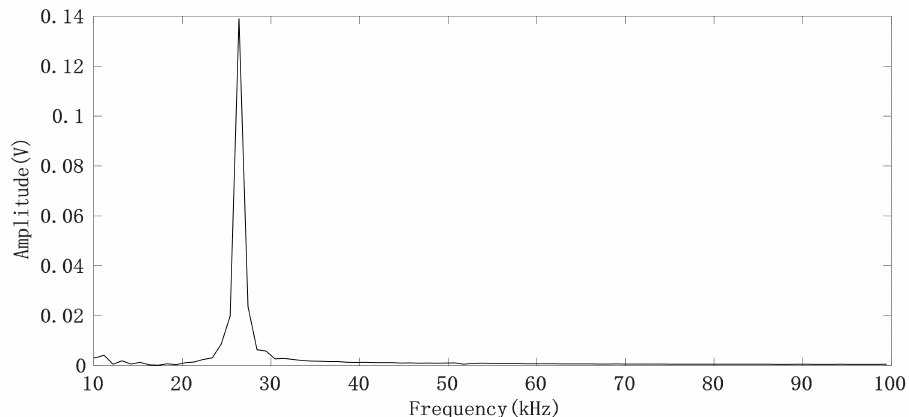
Figure 6. FFT spectrum of the IF signal generated by the FMCW pulse.